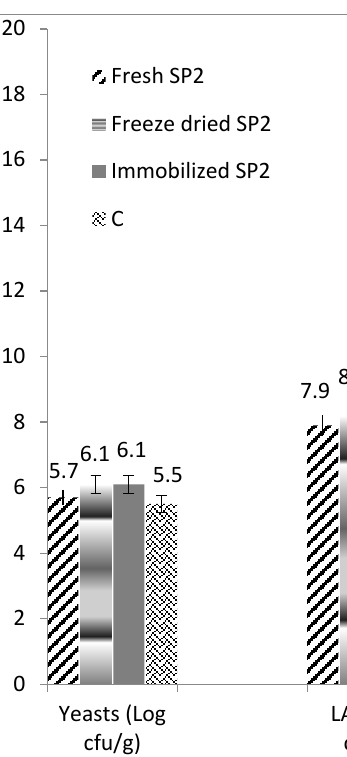
Table 2. SPME GC/MS analysis (semi-quantitative) of flavor- related compounds (μg/g) extracted